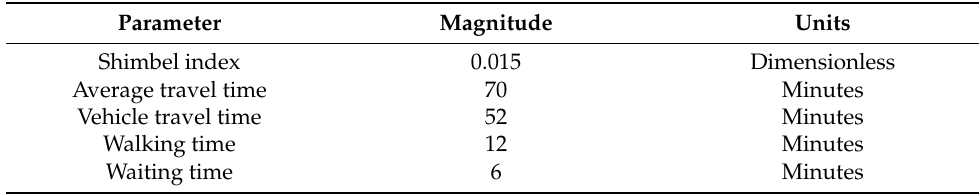
Table 2. Shimbel index and the average travel time.